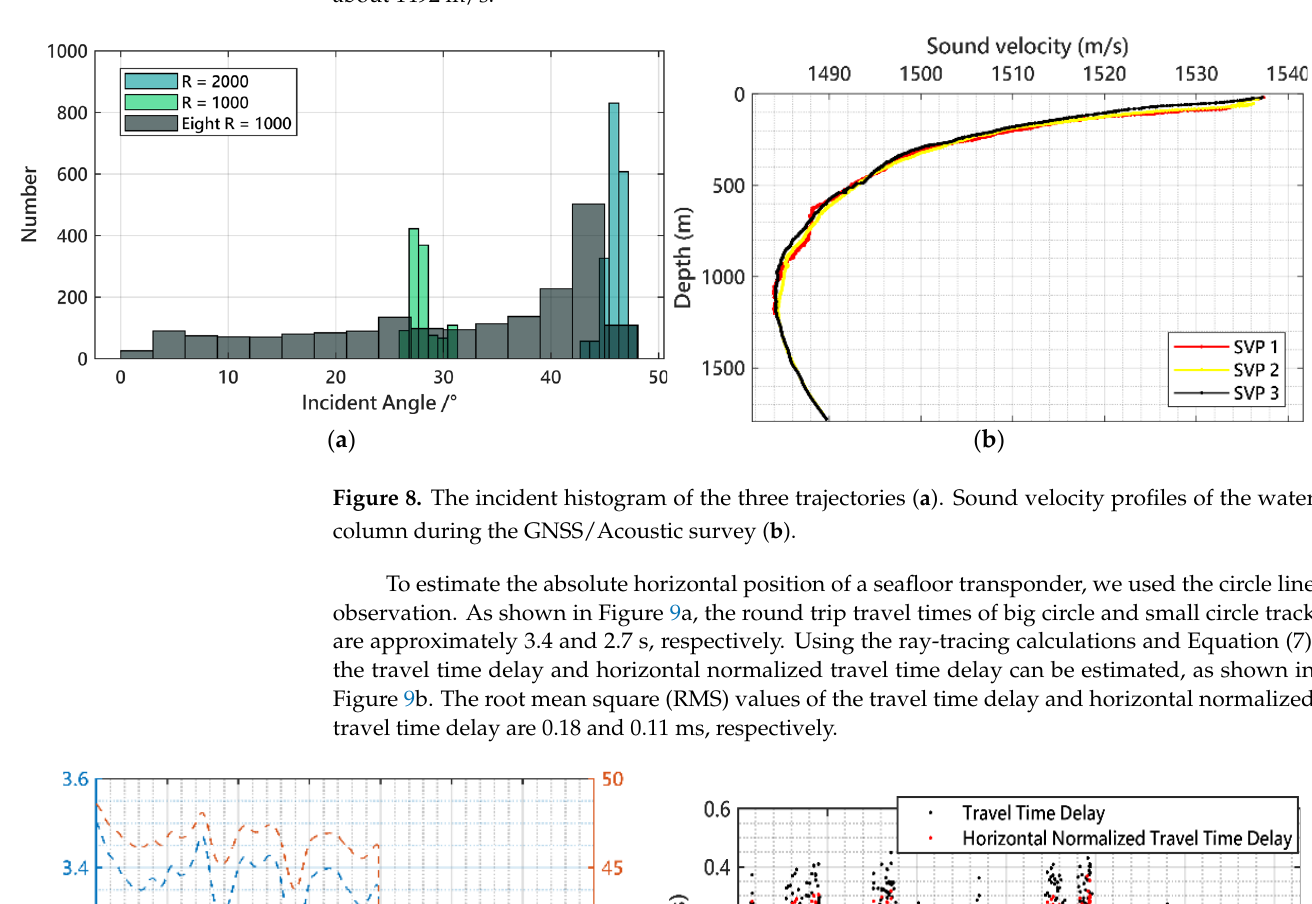
Figure 9b. The root mean square (RMS) values of the travel time delay and horizontal normalized travel time delay are 0.18 and 0.11 ms, respectively.